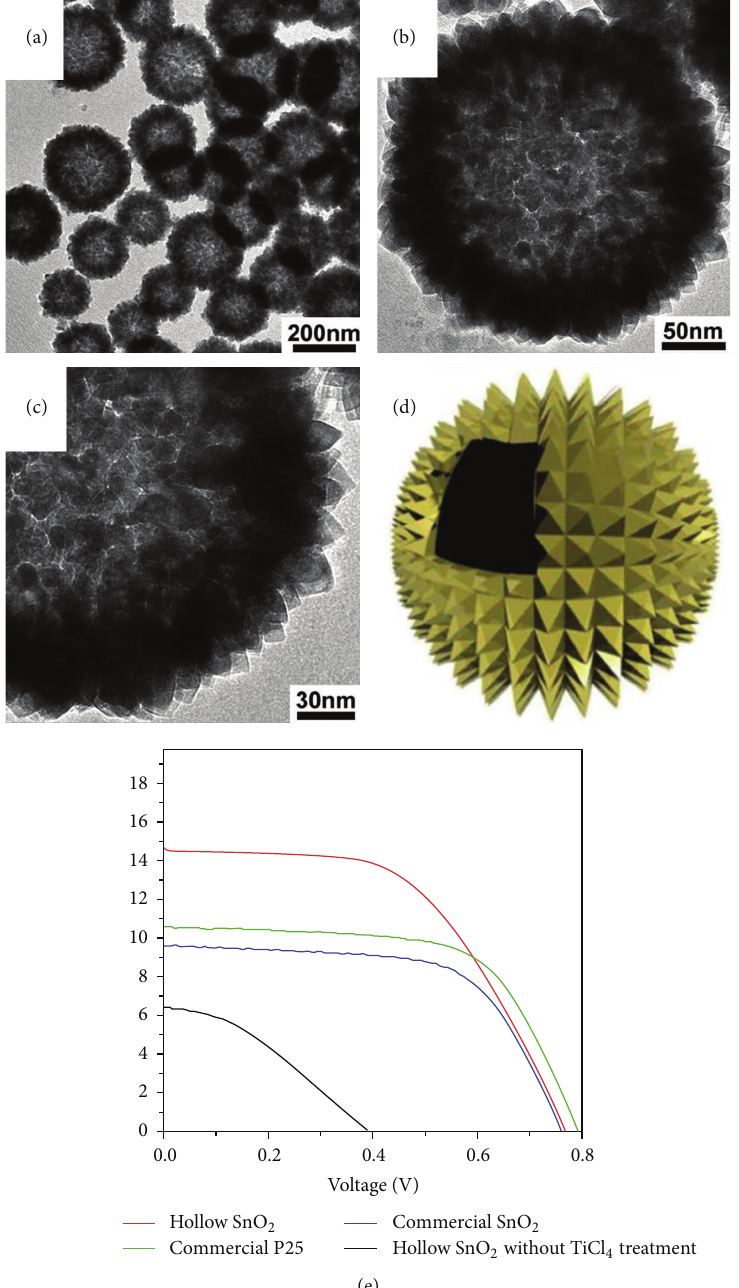
Figure 6: ((a), (b), (c)) TEM images of SnO 2 hollow nanospheres; (d) a schematic image of the hollow sphere; (e) photocurrent-photovoltage characteristicsofDSSCsassembledfromas-preparedSnO 2 hollownanospheres,commercialP25,andcommercialSnO 2 withTiCl 4 treatment, as well as SnO 2 hollow nanospheres without TiCl 4 treatment [110].